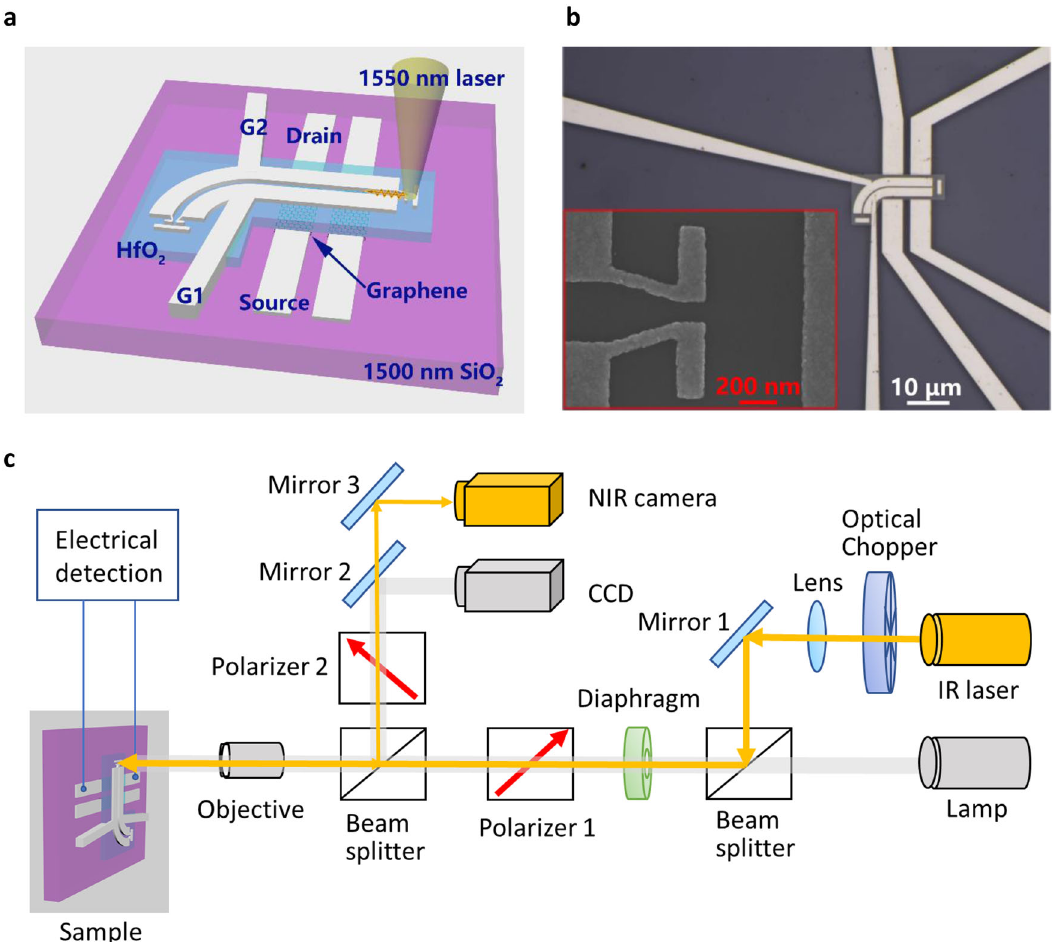
Fig. 2 Experimental setup. a Schematics of the antenna-coupled plasmonic waveguide device. Two pieces of graphene work separately for the optical modulation and electrical detection of the waveguide mode. b A microscope image of one device. Inset shows an enlarged picture of the nano-antenna and the re fl ector taken by scanning electron microscope. c An experimental setup. A lamp and CCD camera were used to locate the sample. A NIR camera was used to detect input and output signals and to measure the light modulation under gating. An optical chopper and lock-in was used to achieve electrical detection of light in the